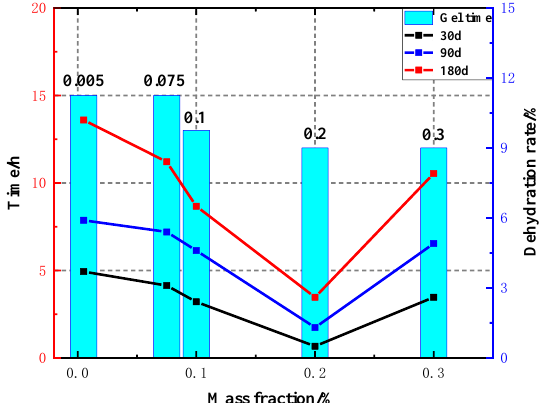
Figure 6. Effect of the crosslinking agent mass fraction on the stability of the frozen gel. Note that the left y-axis values in Figure 6 is used for histograms, and the right y-axis values are used for the line charts; 30 d/90 d/180 d represent 30 days, 90 days, 180 days of dehydration, respectively. Figure 7 is the experimental diagram of the effect of the thiourea mass fraction on the stability of the frozen gel. It can be seen from the experimental results that the dehydration rate of the oxygen scavenger increased from 0.005% to 0.2%, the dehydration rate de- creased significantly, the dehydration rate for 180 days was 2.6%, and the gelation time was 12 h. With an increase in the amount of oxygen scavenger, the gelling time was shortened, but the effect was not obvious; when the oxygen scavenger dosage reached 0.3%, the dehydration rate increased significantly compared with that at 0.2%, indicating that 0.2% oxygen scavenger could help stabilize the frozen gel structure.